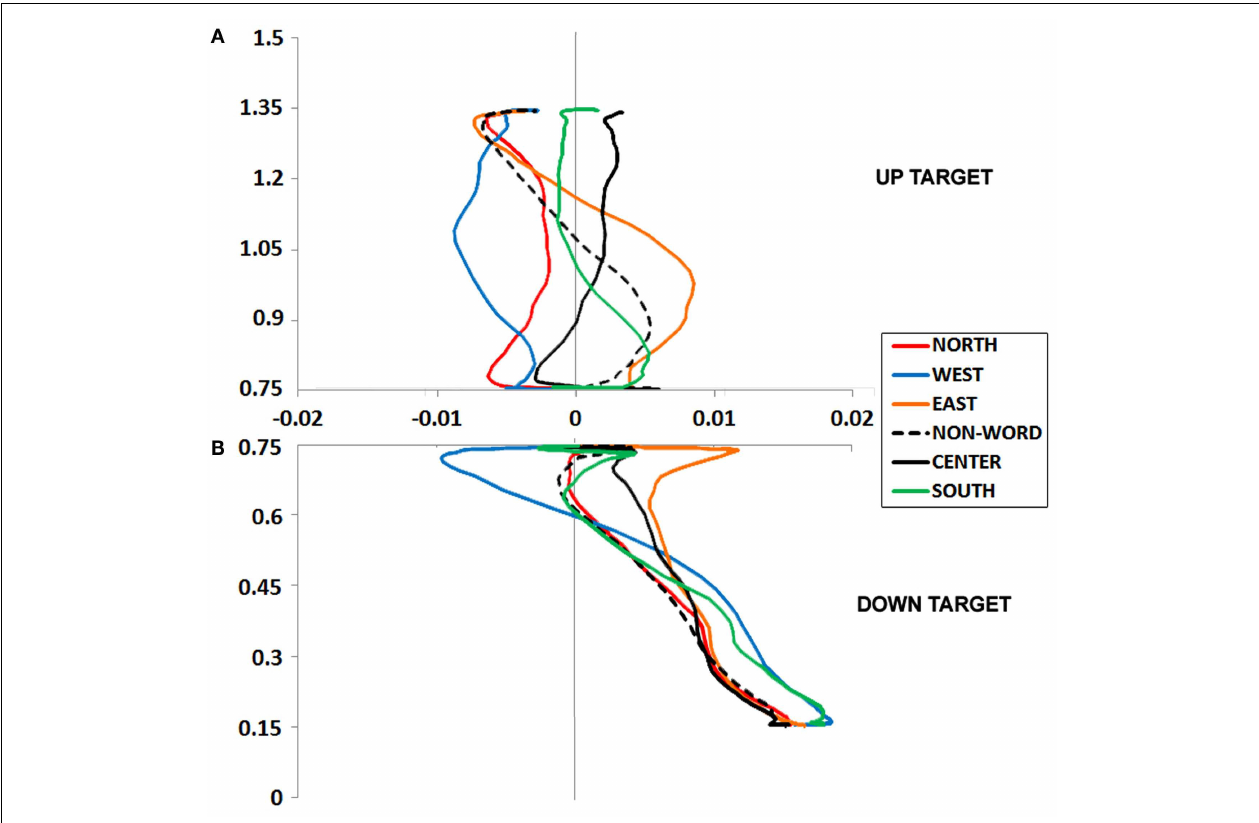
FIGURE 5 | (A,B) Experiment 2 plotted movement trajectory data for the Up (A) and Down (B) target locations, for each of the six PrimeTypes.